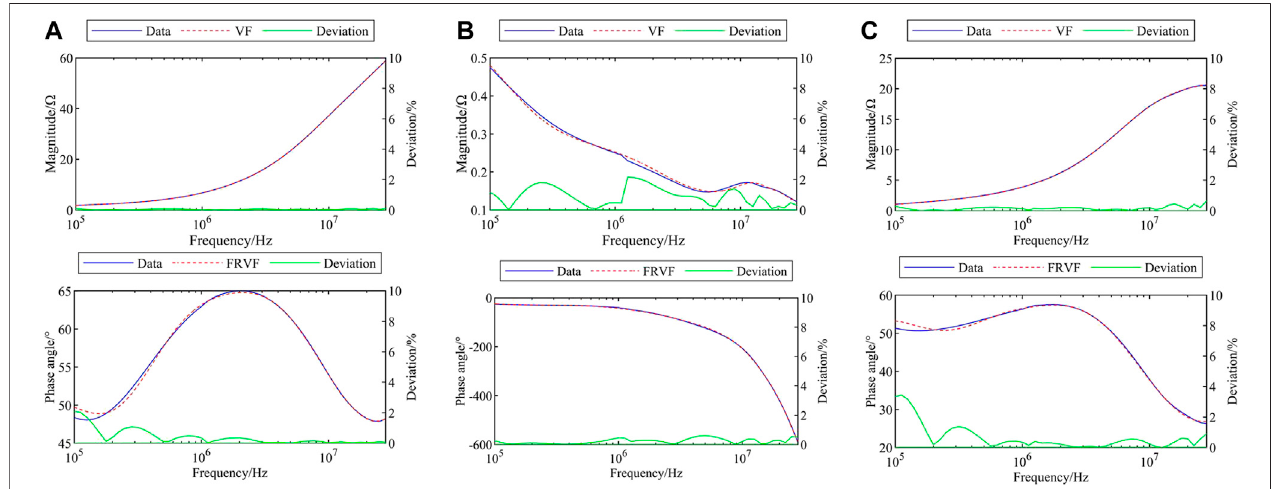
FIGURE 5 | Fitting results of grounding grid model. (A) Fitting results of Z A . (B) Fitting results of Z . (C) Fitting results of Z B .